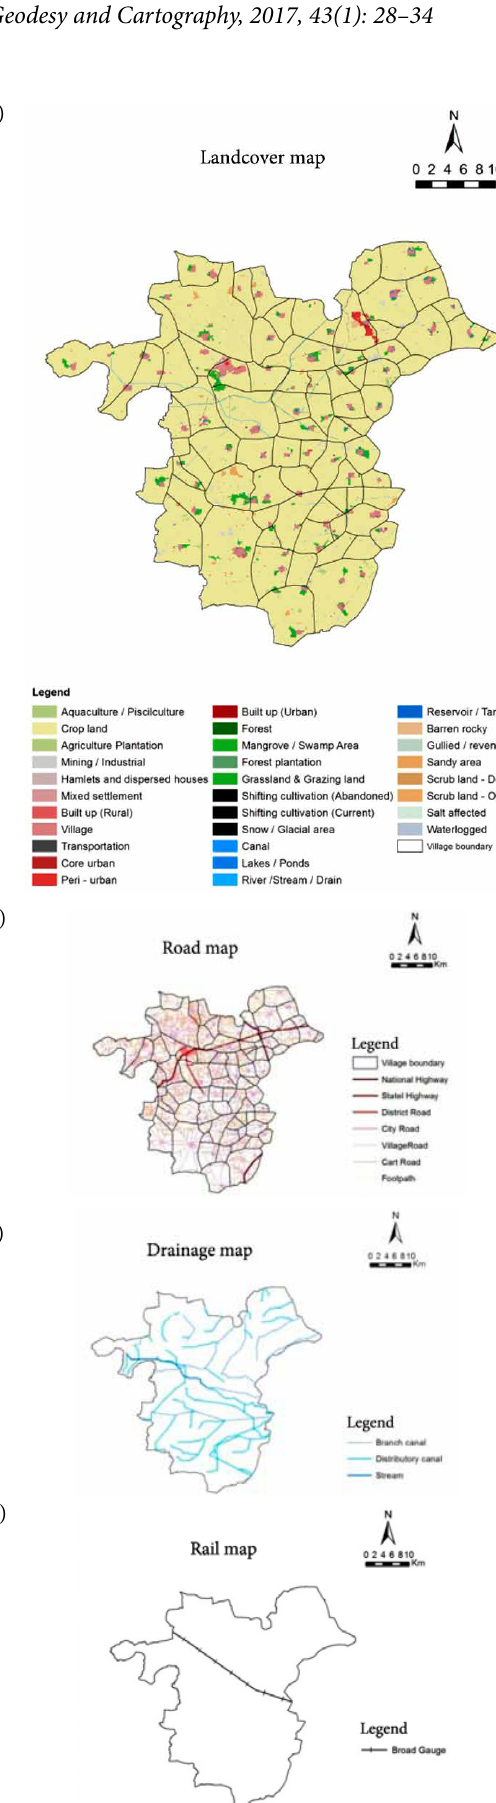
Fig. 4. Plot of Demographic Information: a) No. of Households vs. No. of villages, b) Population vs. No. of